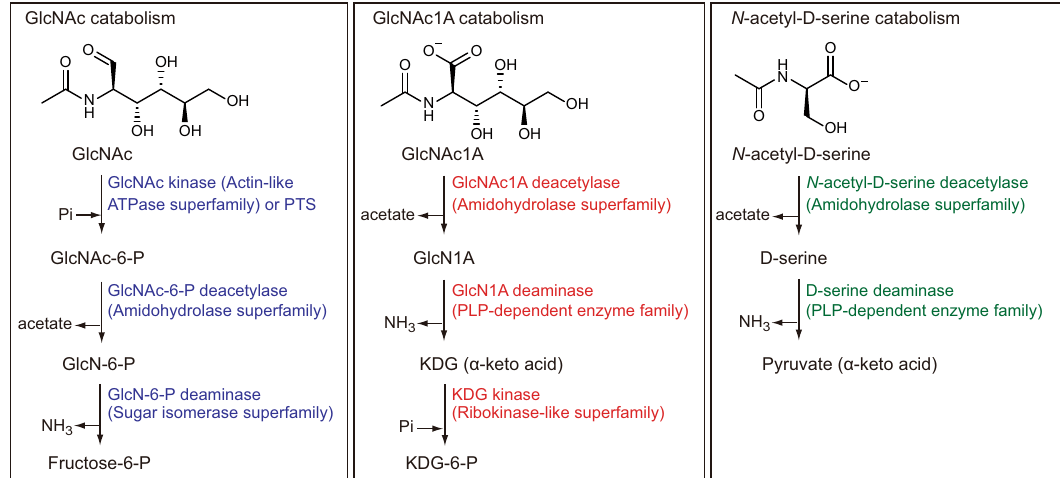
Fig. 1 | The proposed catabolic pathway for GlcNAc1A in this study and reported catabolic pathways for GlcNAc and N -acetyl-D-serine. Catabolism of GlcNAc is initiated by phosphorylation by a GlcNAc kinase (e.g. in Shewanella oneidensis 11 ) or a PTS (e.g. in Vibrionaceae 8,40 ), which is subsequently deacetylated and deaminated to produce fructose-6-P. Catabolism of N -acetyl-D-serine in some bacteria starts with deacetylation followed by deamination and formation of pyruvate 44,54 .IntheproposedcatabolicpathwayforGlcNAc1Ainthisstudy,GlcNAc1A